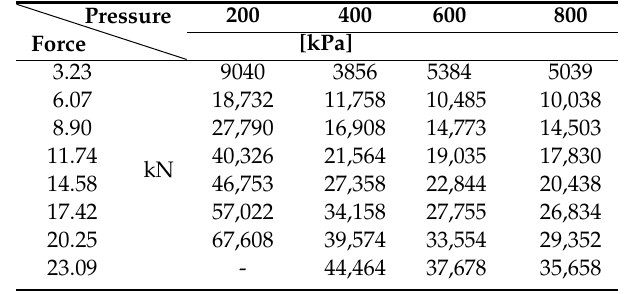
Table 4. Surface area values resulting from testing the Su-22 aircraft tire (results in mm 2